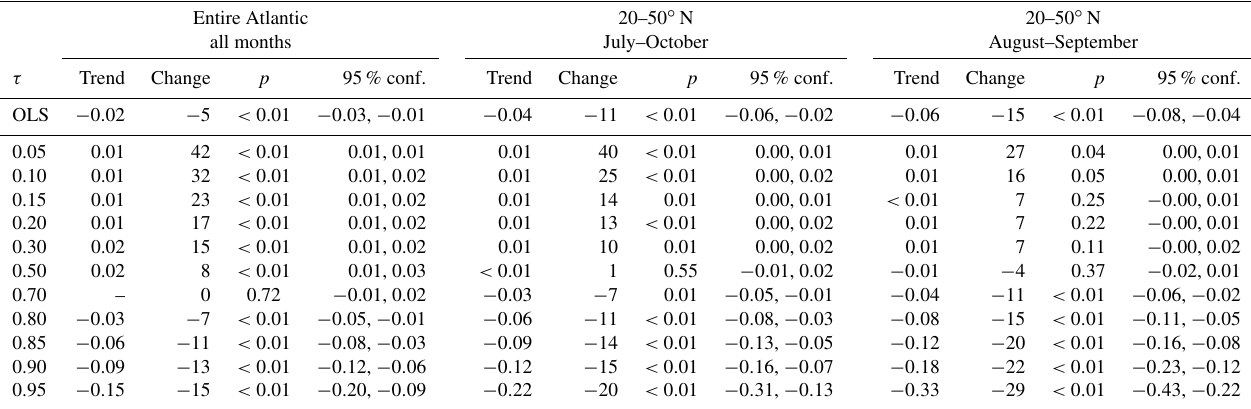
Table 4. Quantile trends of curvature acceleration over 1966–2019 (kmh − 1 d − 1 yr − 1 ) for months and regions labeled below. Trends of magnitude below 0.01 are not reported.